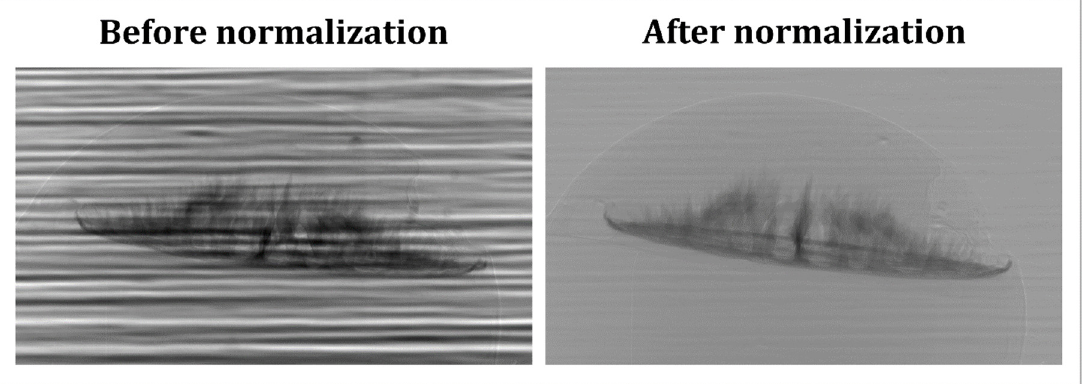
Figure 2. Example X-ray µCT radiographs of a recruit skeleton as obtained on the beamline ( left ) and after normalization ( right ). Radiographs were background-corrected by normalization with empty beam (flat-field) images and by the subtraction of dark-current images. The dark silhouette of the coral is seen to be suspended within a faint halo of epoxy resin, visible in the normalized ( right ) image.